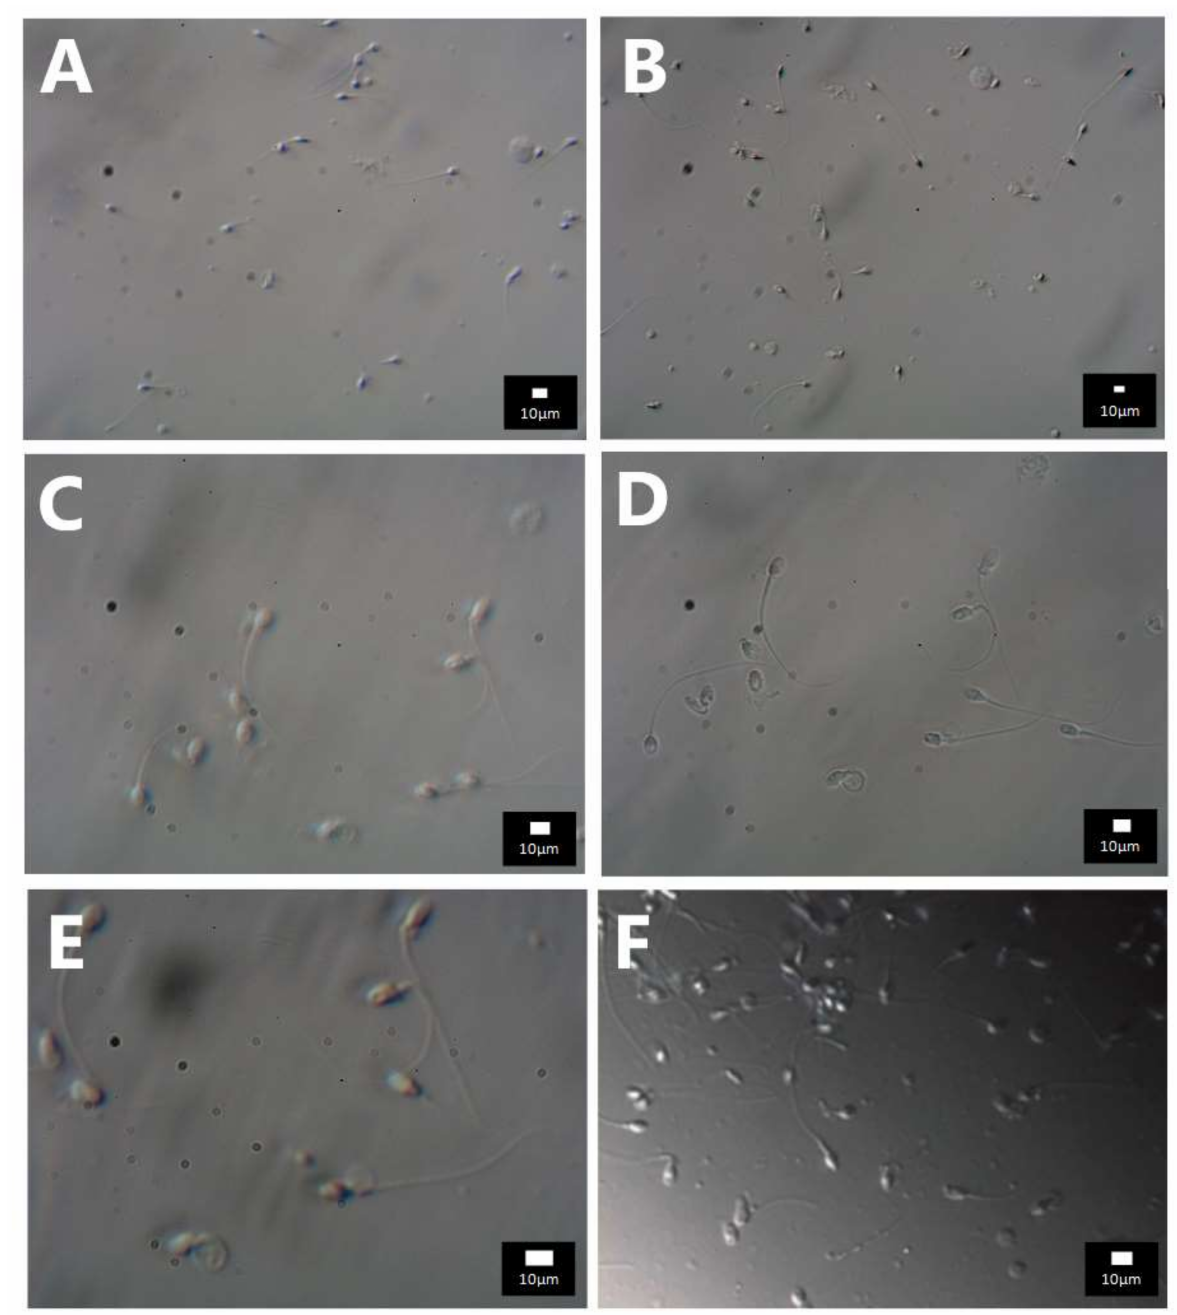
Figure A3. Photos of spermatozoa with HMC. Objectives used with various magnifications and numeric apertures: ( A ) 20 × NA 0.3 (total magnification 200 × )—sperm morphology details are not discernible, ( B ) 20 × NA 0.45 (total magnification 200 × )—larger vacuoles become visible, ( C ) 40 ×